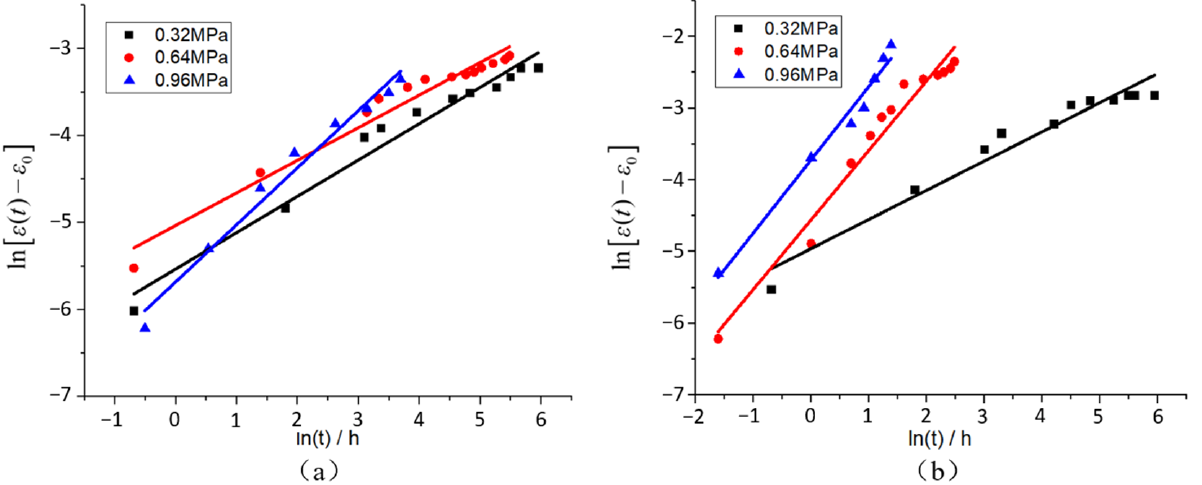
Figure 6. Creep strain fitting curve in double log coordinates: ( a ) HT, ( b ) HTAH. Table 4. Characteristic parameters of fitted curves in different environments. Parameter